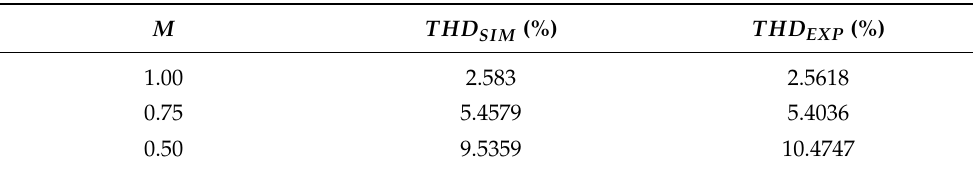
Table 4. THD for different modulation